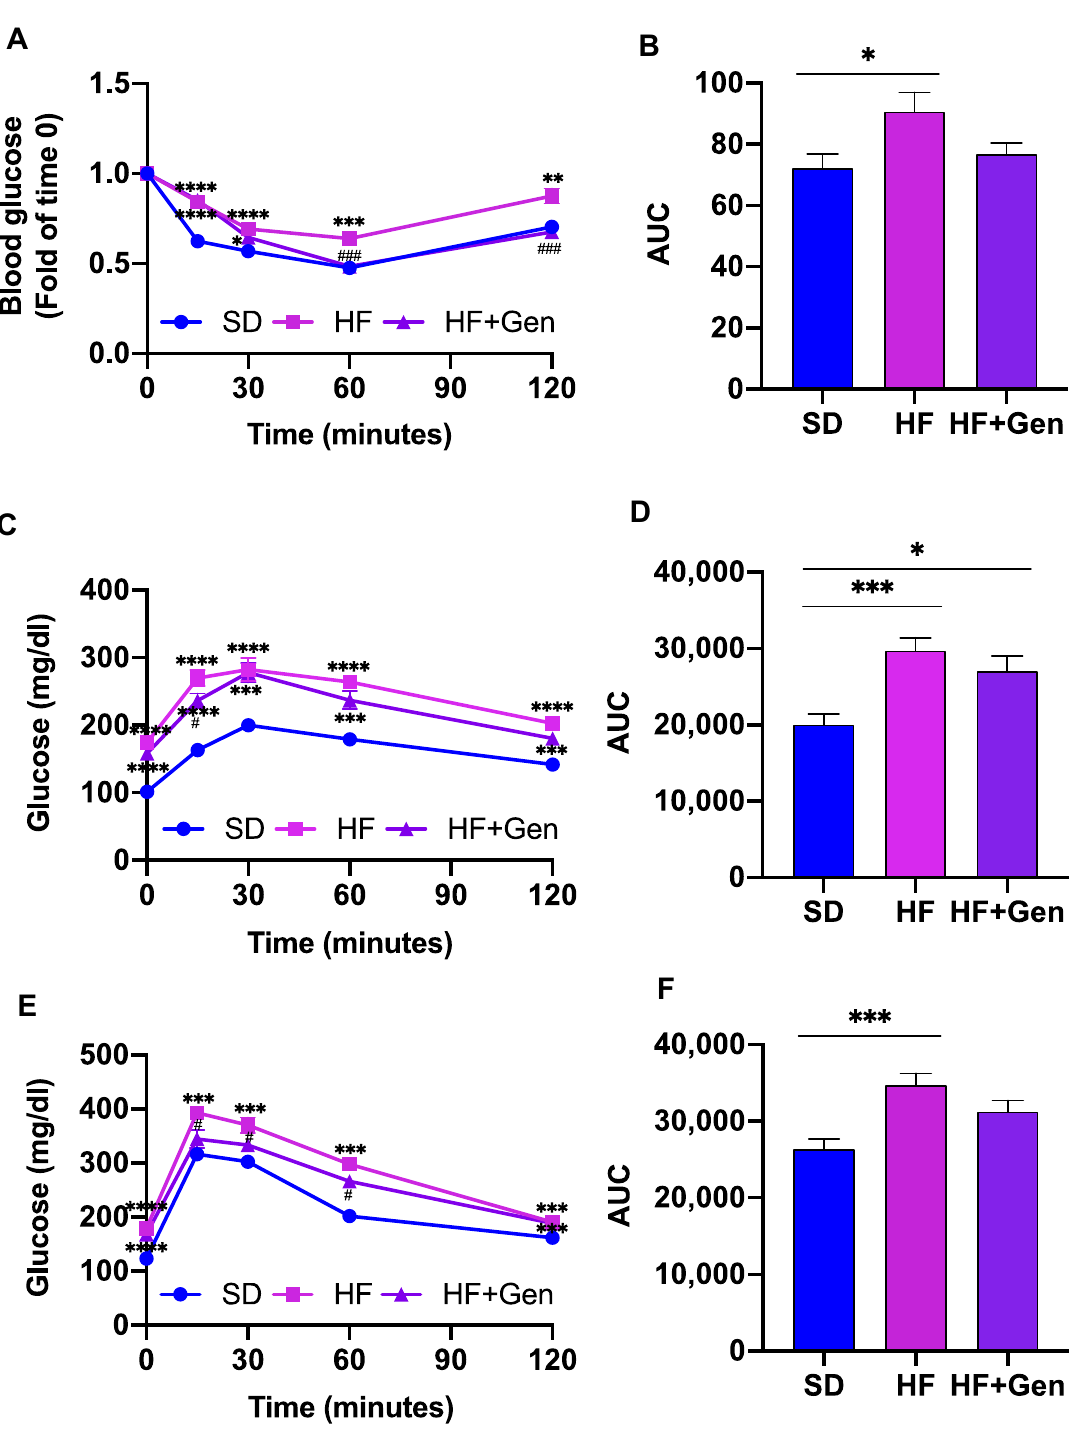
(Figure 5E,F), whereas it had no significant effect on pyruvate tolerance (Figure 5C,D), suggesting that genipin may not modulate hepatic gluconeogenesis.